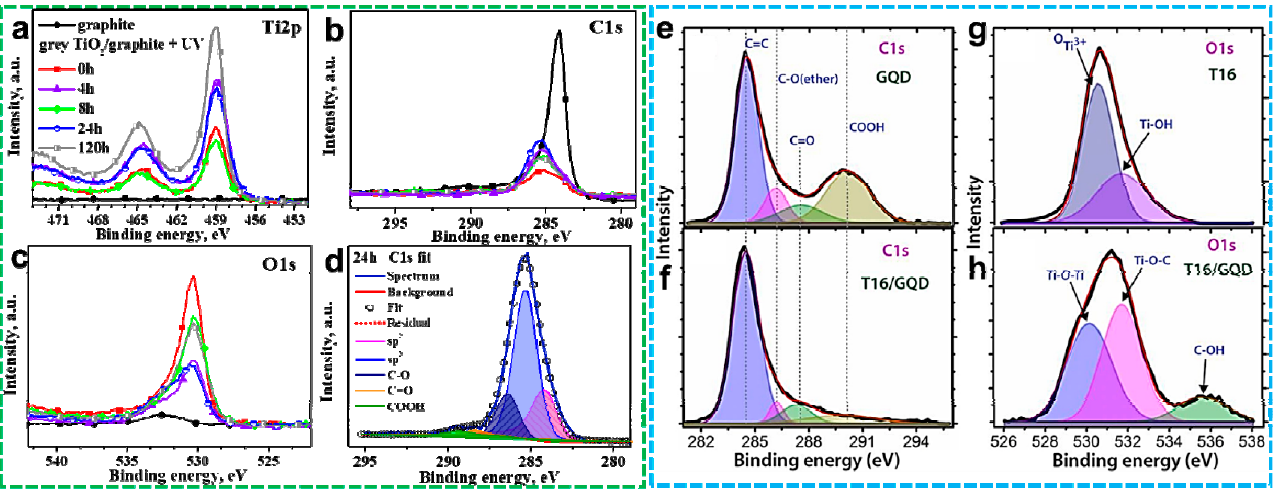
Figure 6. High-resolution XPS analysis: ( a – c ) raw data of Ti2p, C1s and O1s peak of the TiO 2 -GO composite (increases in time show oxidation level of GO), ( d ) C1s spectra of 24 h UV-illuminated composites [10] (Reprinted with permission from [10] Copyright 2022 John Wiley & Sons, Inc.), Composites of GO quantum dots (gQD) and TiO 2 (T16) with the corresponding peak fittings for the ( e , f ) C1s spectra (GQDs and the T16/GQD composite) and the ( g , h ) O1s spectra (T16 and T16/GQD) [167] (Reprinted with permission from [167] Copyright 2018 Elsevier Ltd.).